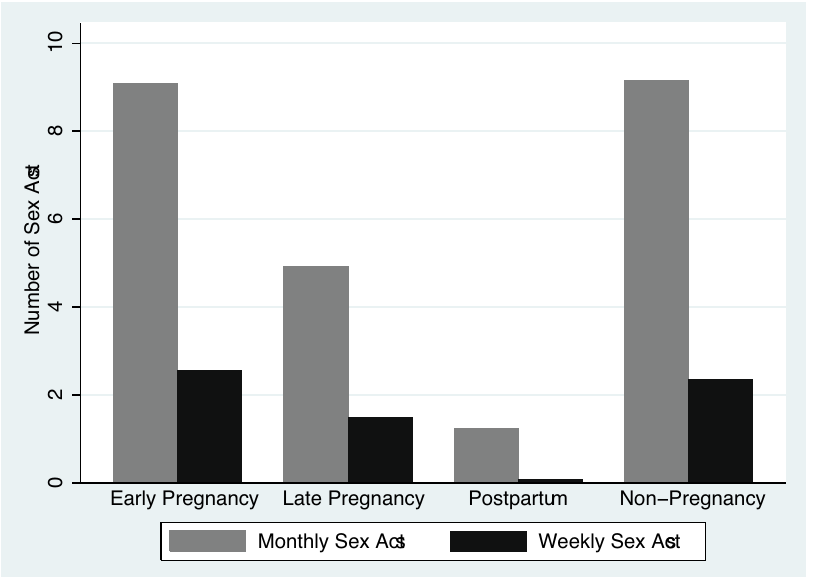
Figure 2. Average Monthly and Weekly Sex Acts among early pregnancy, late pregnancy, postpartum, and non-pregnant study groups. Early pregnancy and non-pregnancy sexual activity was similar and significantly exceeded that of the late pregnancy and postpartum groups when comparing both weekly and monthly sex acts.